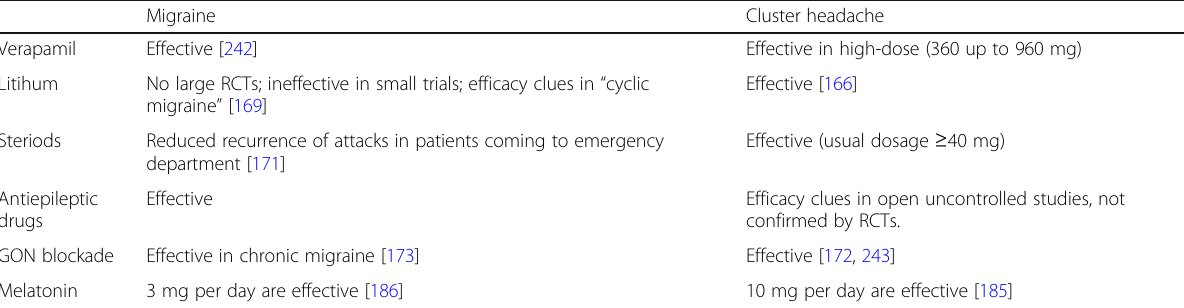
Table 5 Efficacy of preventive therapies in migraine and cluster headache Migraine Cluster